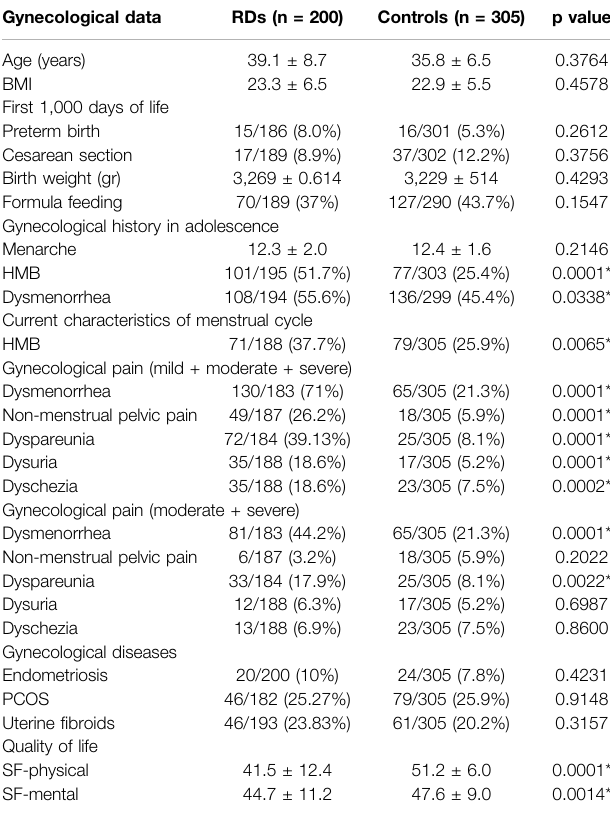
TABLE 3 | Gynecological data of rheumatic diseases vs controls: fi rst 1,000 days of life, gynecological history, and menstruation-related